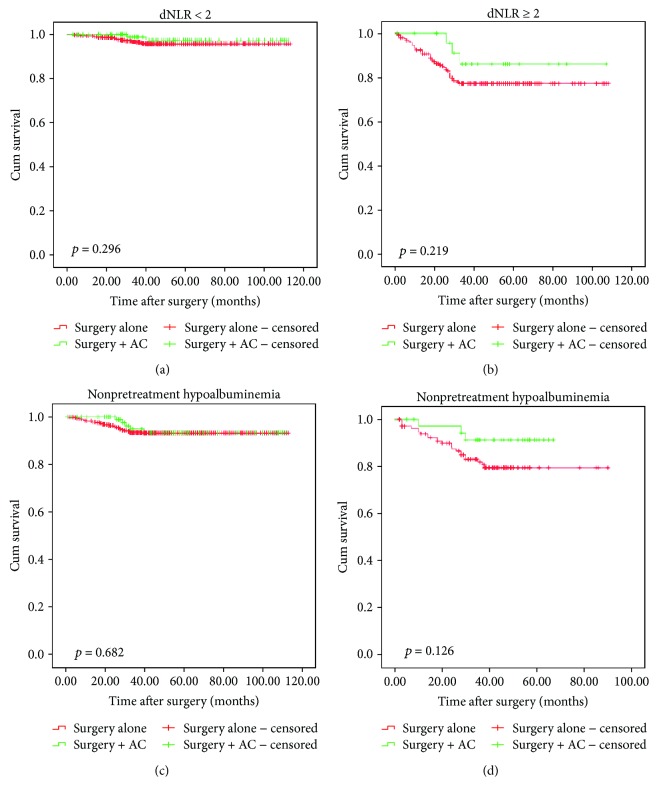
Comparison of OS between adjuvant chemotherapy group and surgery-only group. (a) dNLR < 2 subgroup, (b) dNLR ≥ 2 subgroup, (c) hypoalbuminemia subgroup, and (d) nonhypoalbuminemia subgroup.